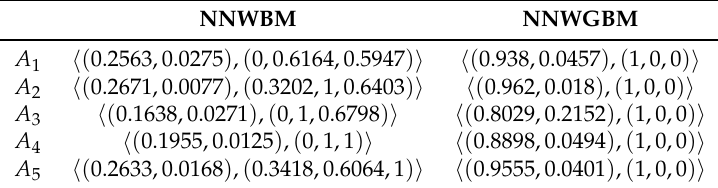
Table 14. Liu and Li’s method [6] (the NNWBM operator and NNWGBM operator p = 14, q =